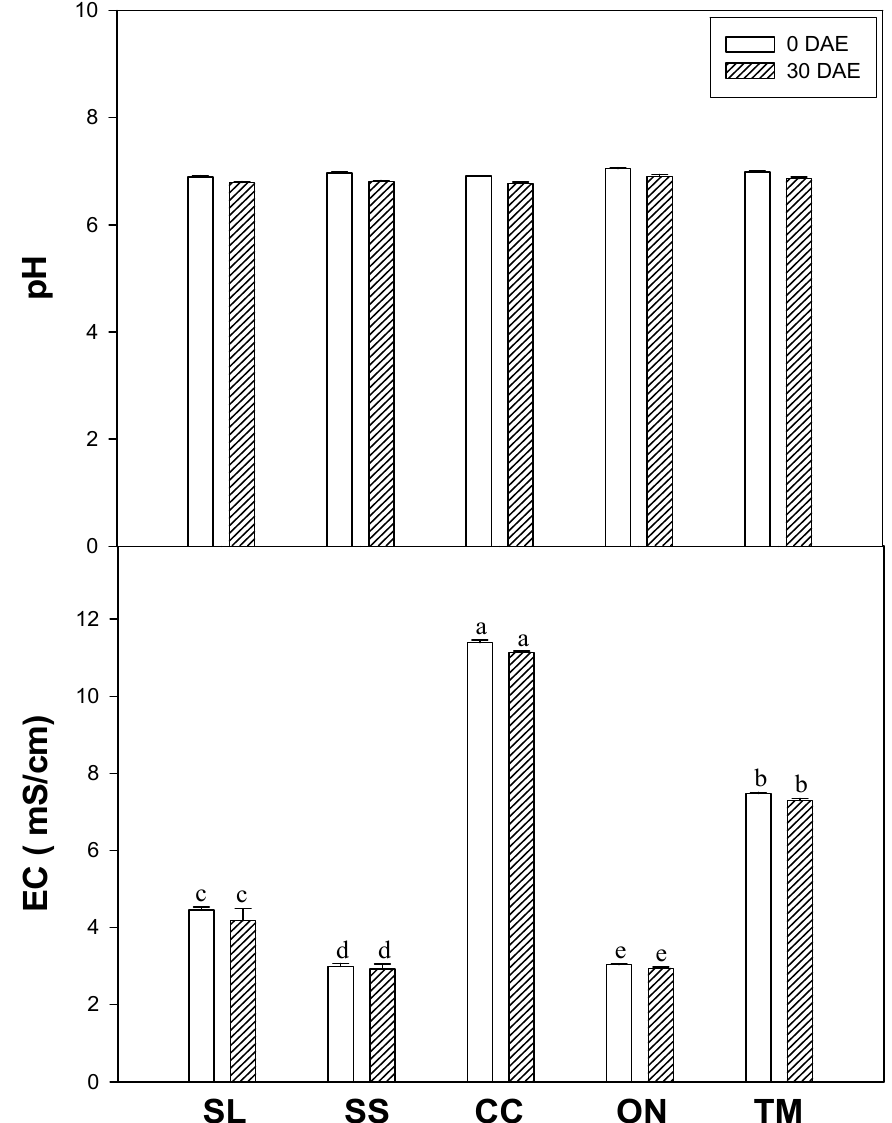
Figure 2. pH and EC values in various plant extracts (SL, soybean leaf; SS, soybean stem; CC, Chinese chive, ON, onion; TM, tomato) at 0 and 30 days after extract (DAE). Means within bars followed by the same letters are not significantly different at the 5% level according to Duncan’s Multiple Range Test.